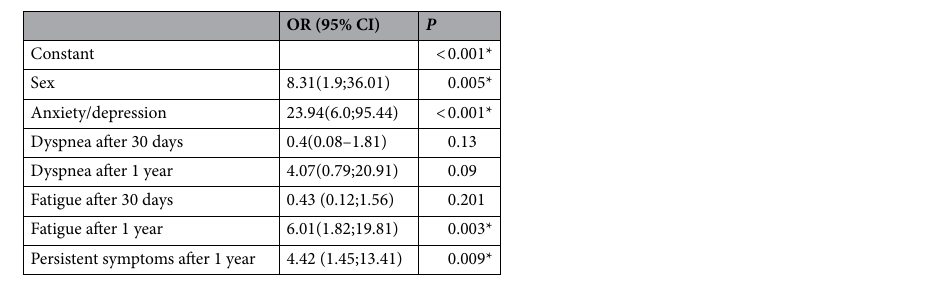
Table 4. Multivariable analysis of functional limitations after one year and predictor variables. Source : Prepared by the authors (2022). Chart legend: OR: odds ratio; CI: confidence interval; * P ≤ 0.05.